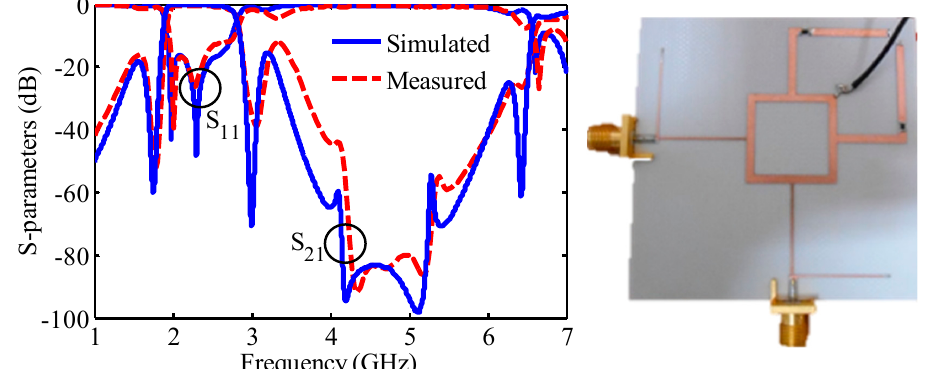
Figure 12. Simulated and measured S -parameters results of reconfigurable bandwidth BPF with 3 λ g /4 open-ended stubs for wideband state.